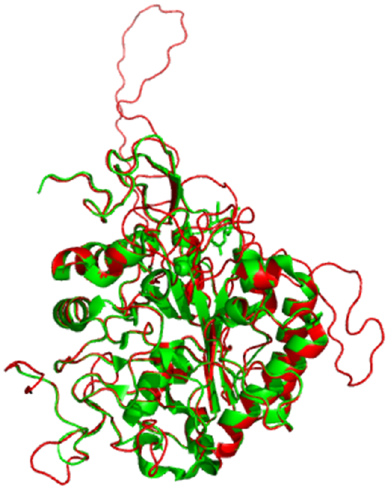
Figure 3. Overlap between alpha-carbons of macromolecule 5ZNT (green) and the Bombyx-Aedes model (red); RMSD value 0.396.